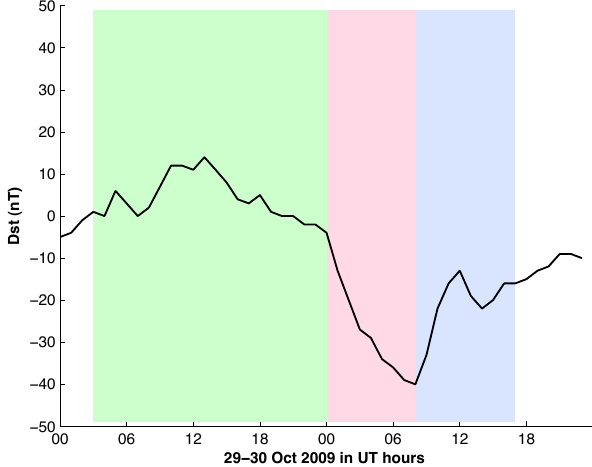
Fig. 2. An example of storm phases identified from Dst index: Initial phase in light green, main phase in pink and recovery phase in light blue shading. Table 1. Activity index median values during all substorm phases. The last row gives the mean duration values for the different